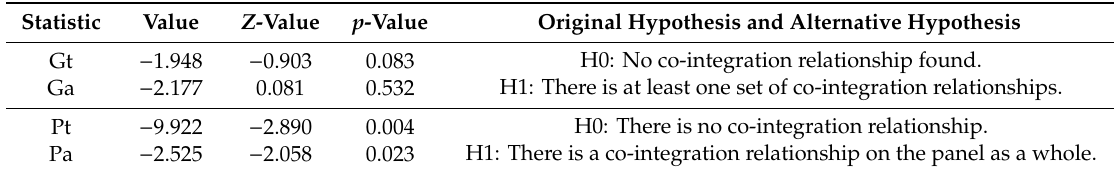
Table 5. Panel cointegration test